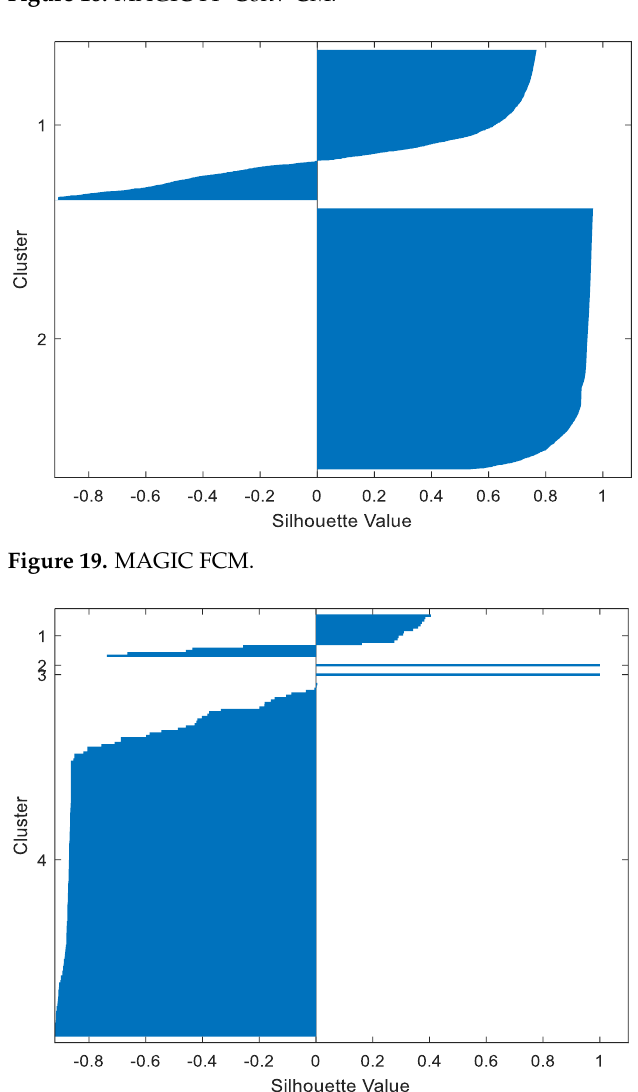
Figure 20. MAGIC Figure 20. MAGIC GMM.